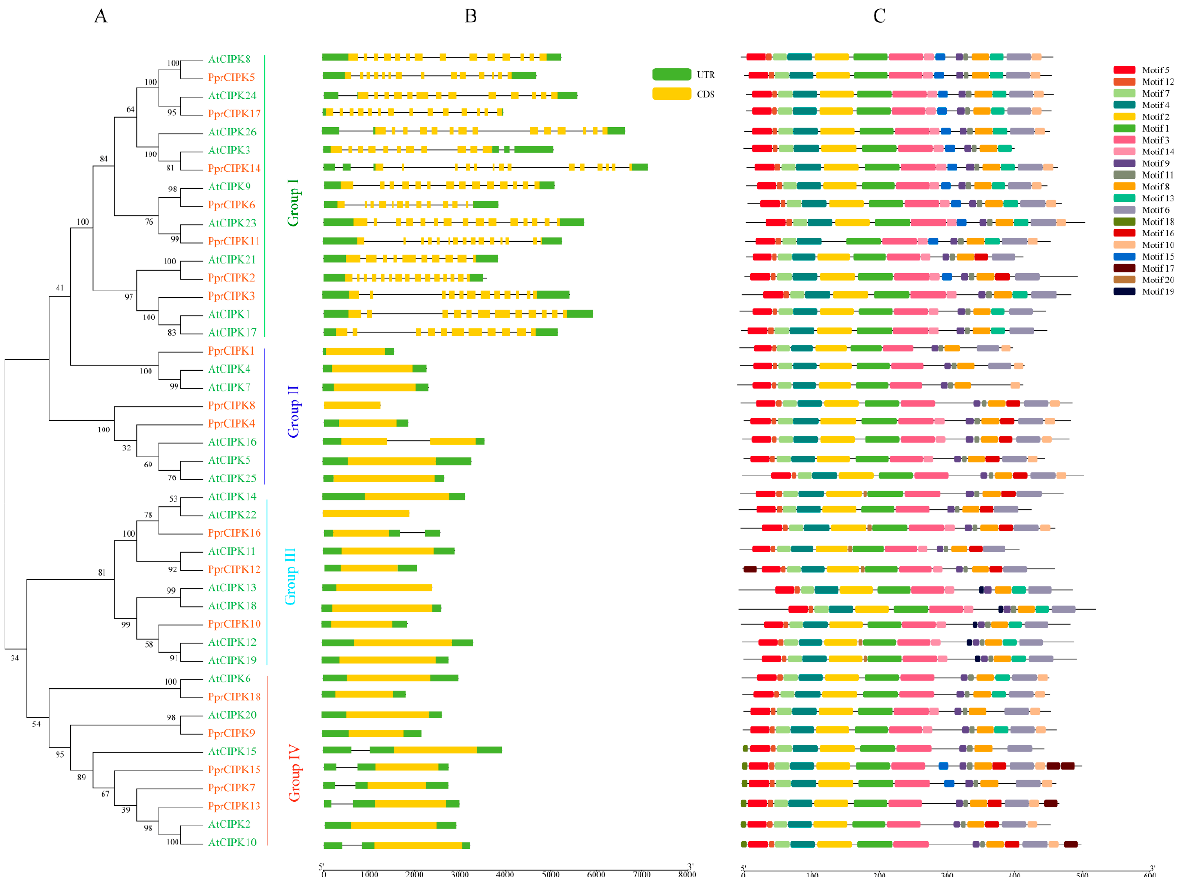
Figure 2. Phylogenetic, structure and motif analysis of CIPK gene families from peach and Arabidopsis. ( A ) The phylogenetic analysis of CIPK; different colored arcs represent different subgroups. ( B ) The gene structure analysis of the CIPK members; the green rectangle represents the untranslated region (UTR), and the yellow rectangle represents the coding sequence (CDS). ( C ) The conserved motif analysis of each CIPK members; different colored rectangles represent different motifs.